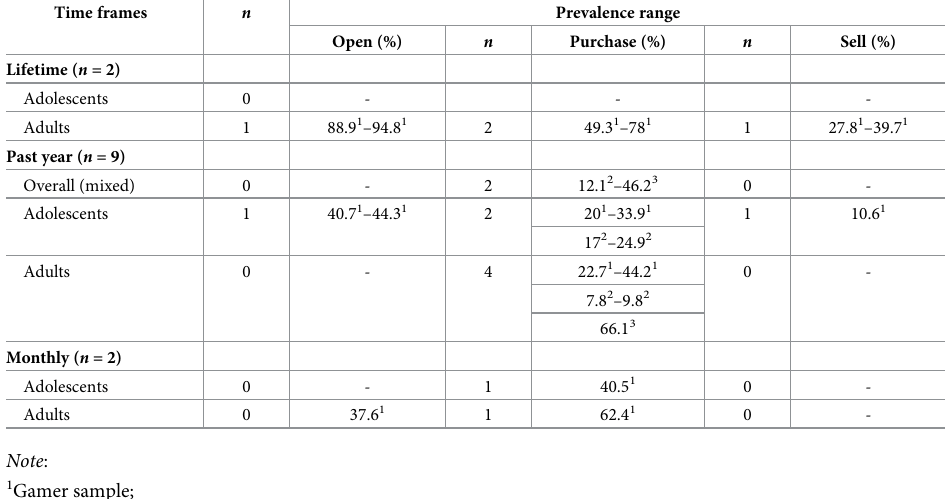
Table 2. The overall prevalence of engagement with loot boxes according to time frame, age group, and action taken ( N = 16). Time